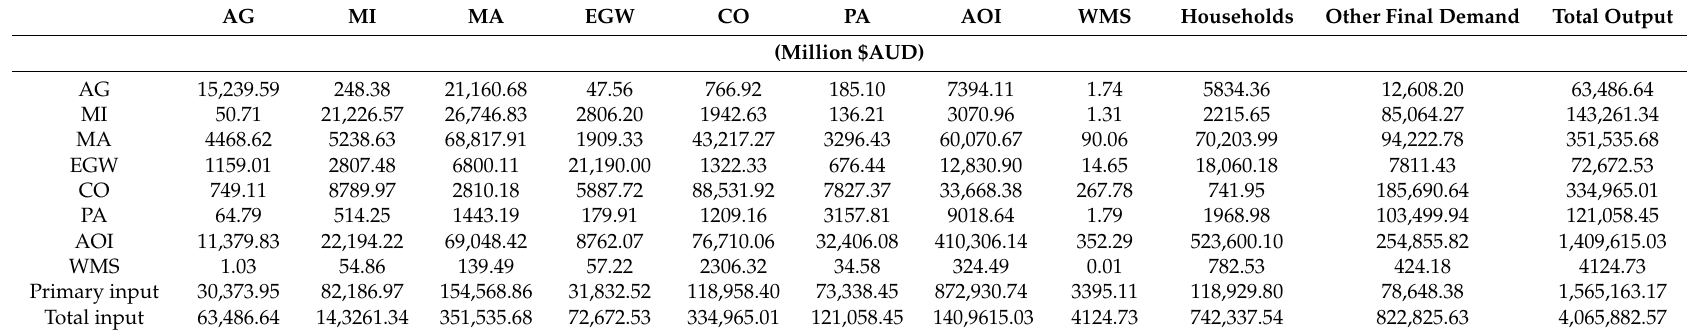
Table 5. The extrapolation of Australian aggregation input-output table (IOT) of